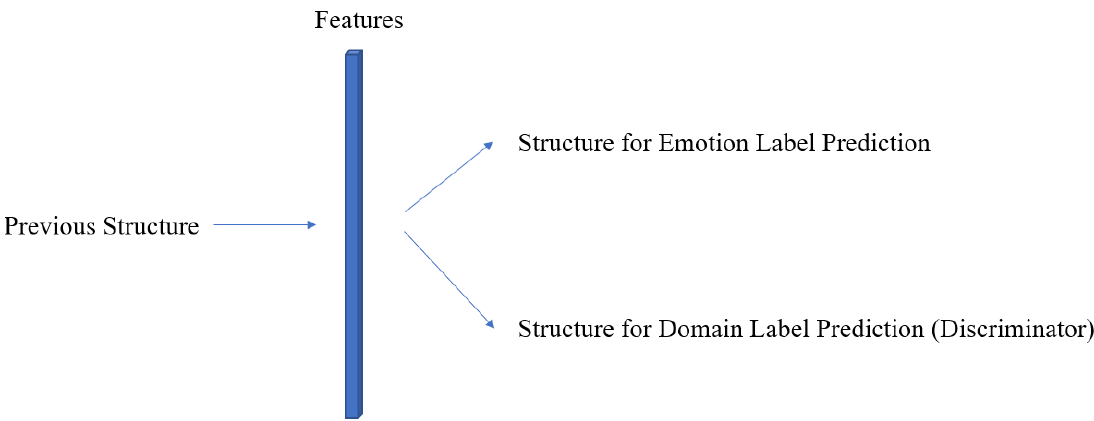
Figure 10. Features from a previous structure are processed both by the structures for emotion pre- diction and the discriminator.